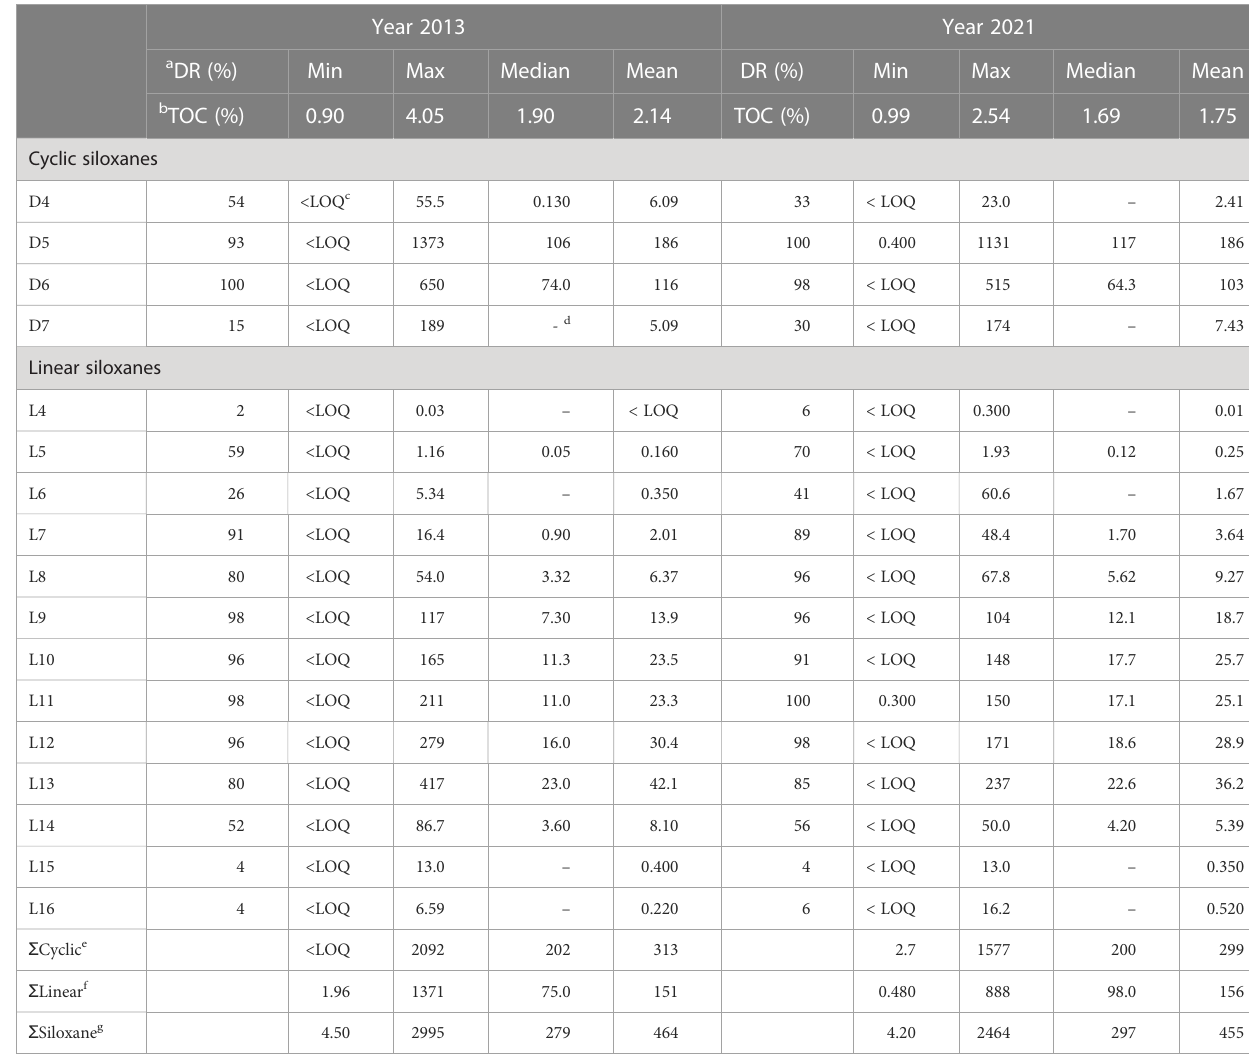
TABLE 1 Summary of concentrations (ng/g dry weight) of cyclic and linear siloxanes in sediment collected from Masan and Haengam Bays of Korean in 2013 and